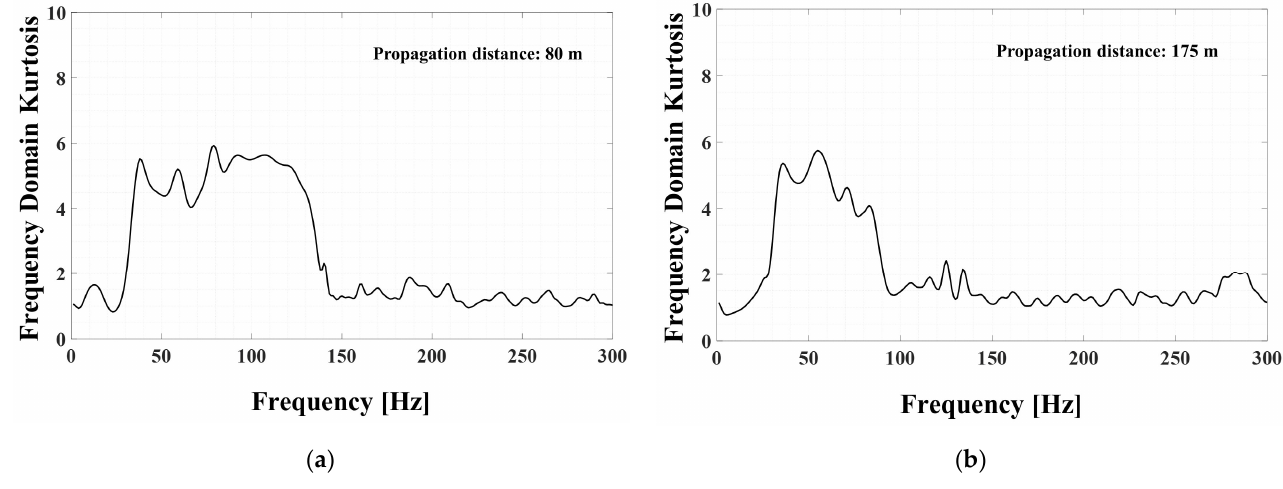
Figure 15. FDK obtained from each sensor: ( a ) sensor 1 and ( b ) sensor 2.